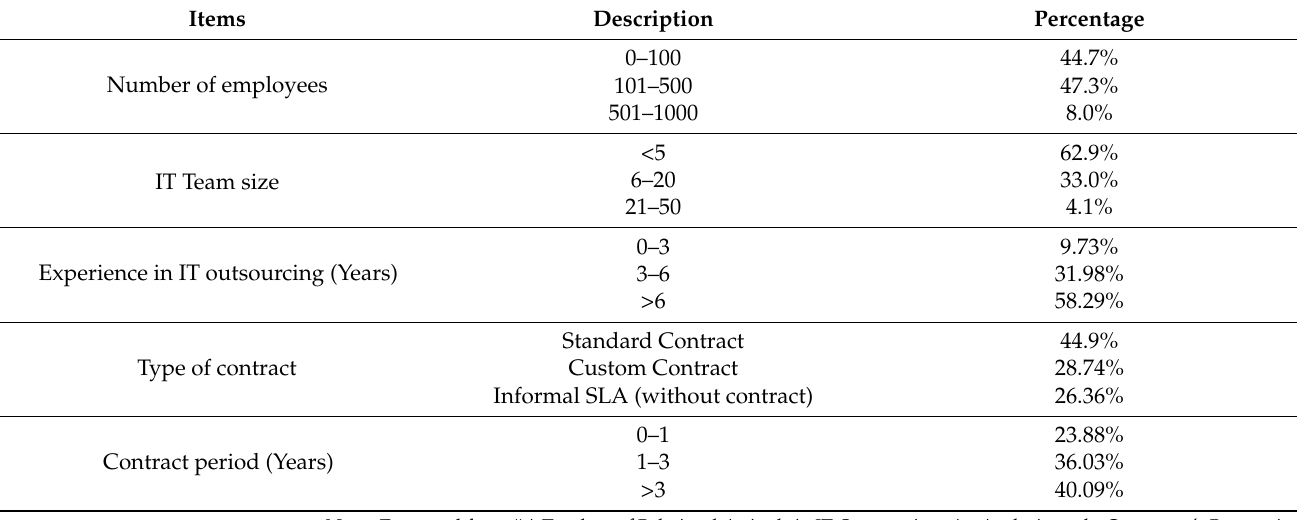
Table 2. Participating companies’ summary according to Poleto et al.